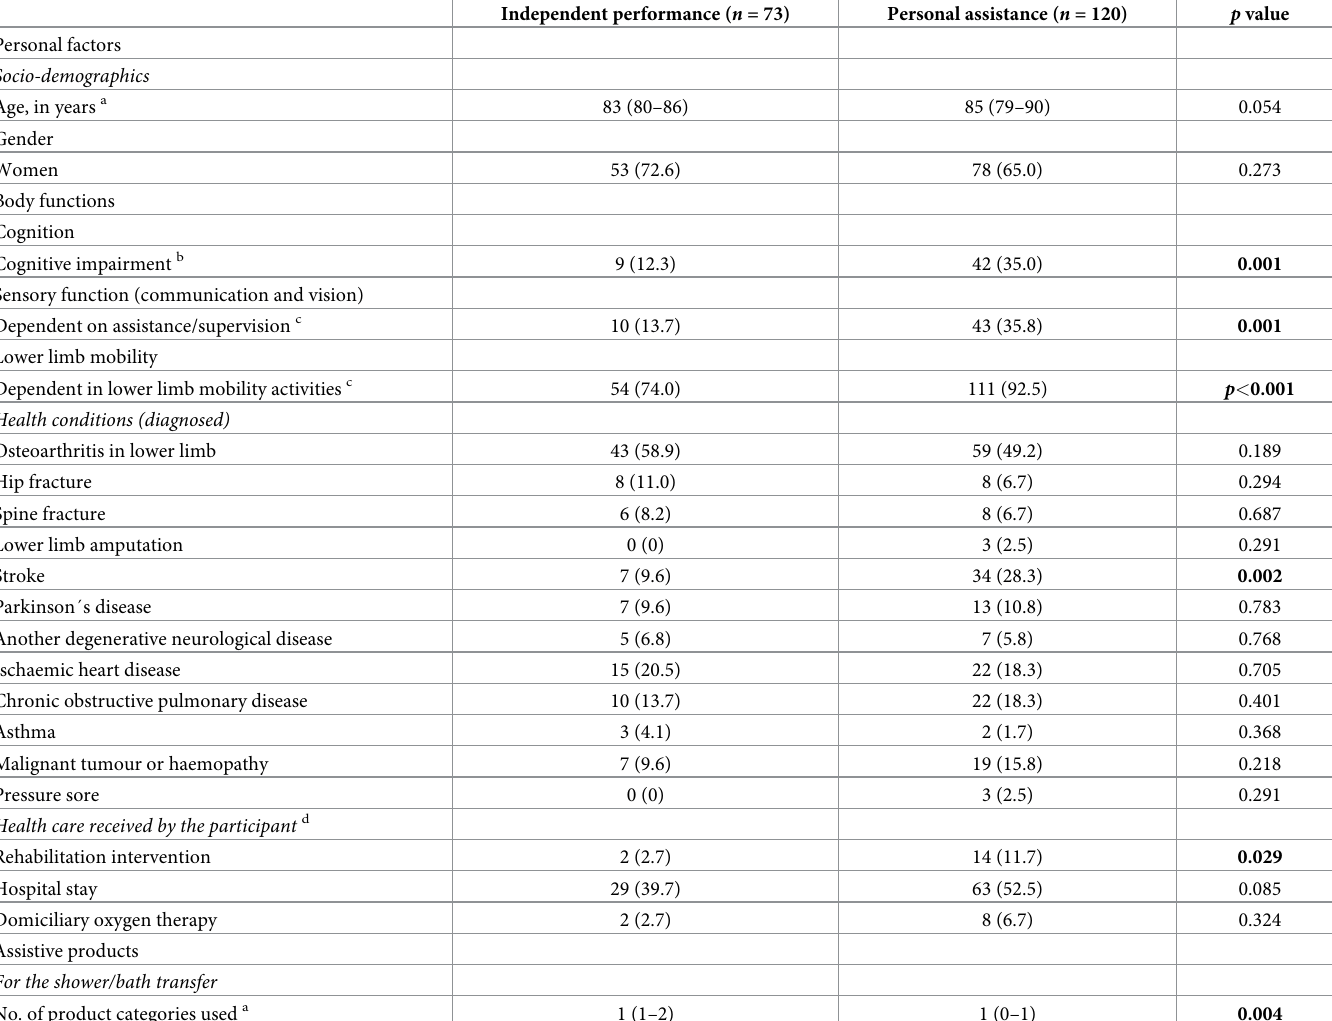
Table 2. Bivariate relationship between independence functional in the performance of the transfer to the shower/bath and personal factors and assistive products ( n = 193).